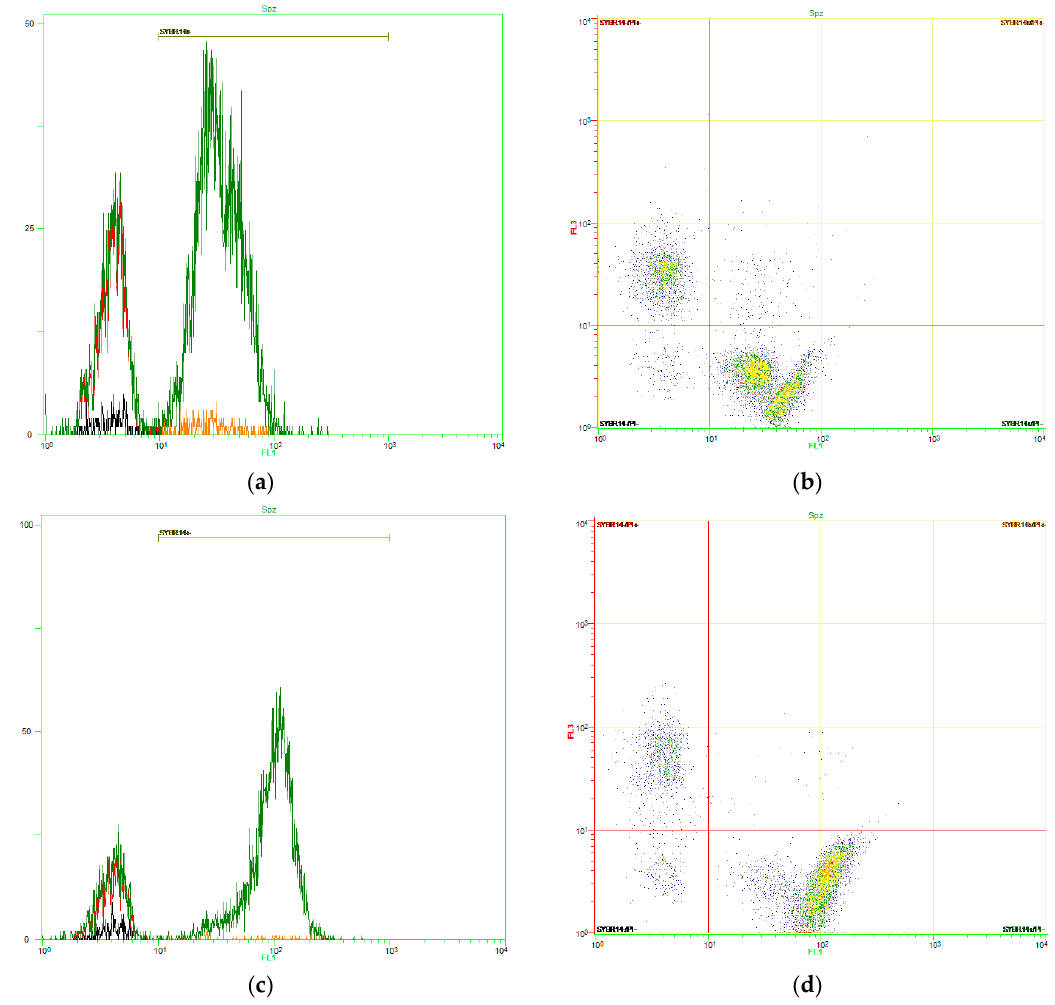
Figure 1. Sperm viability (SYBR14/PI). Representative SYBR14 (FL1) histograms for the control ( a ) and 15-15-15 light-stimulation pattern ( c ). Representative FL1/FL3 dot-plots for the control ( b ) and 15-15-15 light-stimulation pattern ( d ). Viable spermatozoa (SYBR14 + /PI - ) appear in the lower right quadrant. No significant differences between the control and treatments were observed ( p > 0.05).